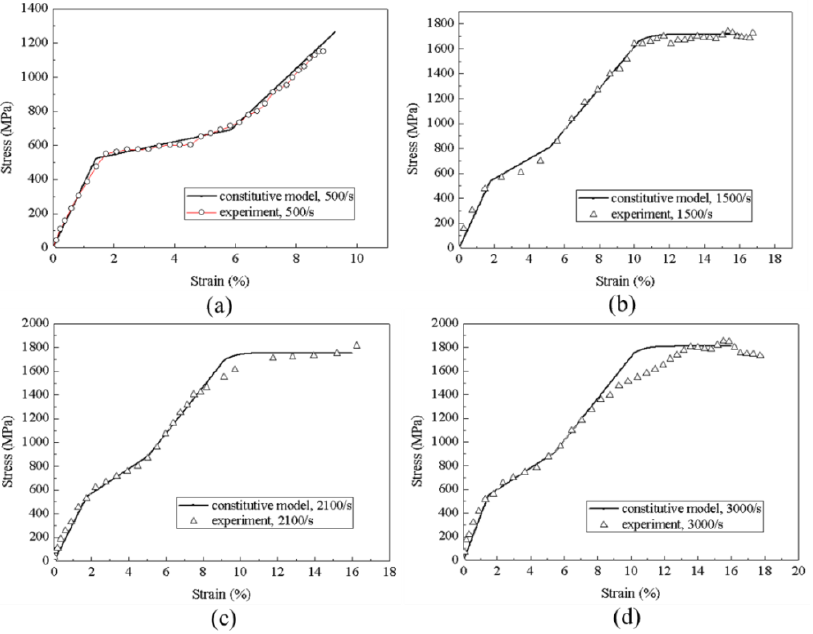
Figure 4. Dependence of the stress – strain response on various strain rates of ( a ) 500/s; ( b ) 1500/s; ( c ) 2100/s; ( d ) 3000/s. ( c ) 2100/s; ( d ) 3000/s.